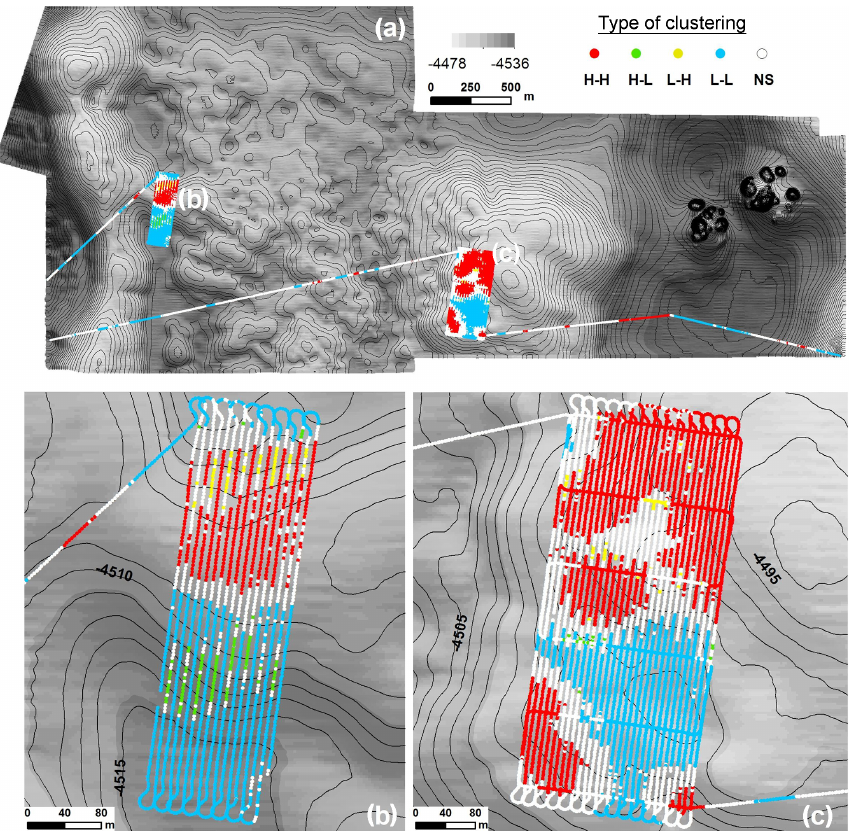
Figure 5. (a) The spatial distribution of the significant cluster types inside the block G77. (b) The spatial clusters inside the subarea b. (c) The spatial clusters inside the subarea (c) .